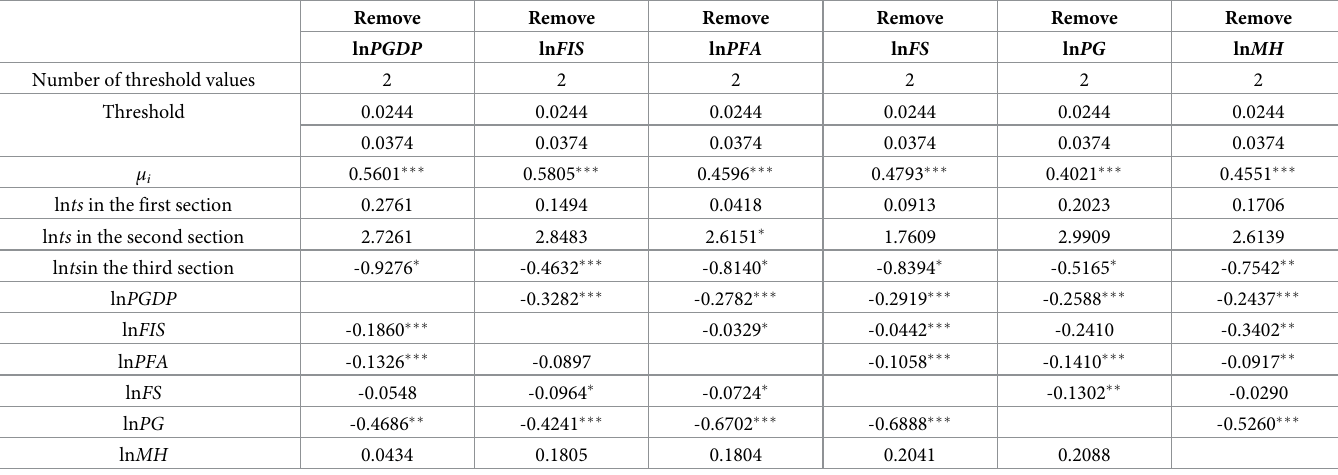
Table 7. Regression results with one control variable removed one by one.